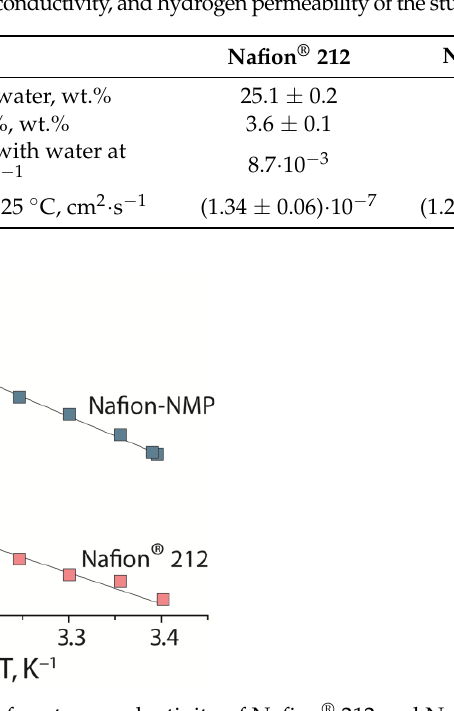
Figure 4. Temperature dependence of proton conductivity of Nafion ® 212 and Nafion-NMP mem- branes in contact with water.